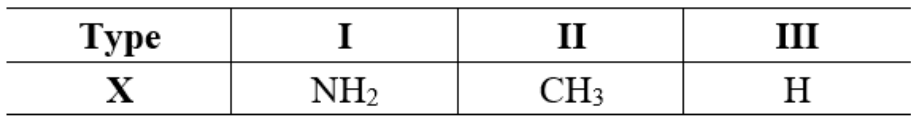
Figure 1. General structure of the studied metal-phthalocyanines.